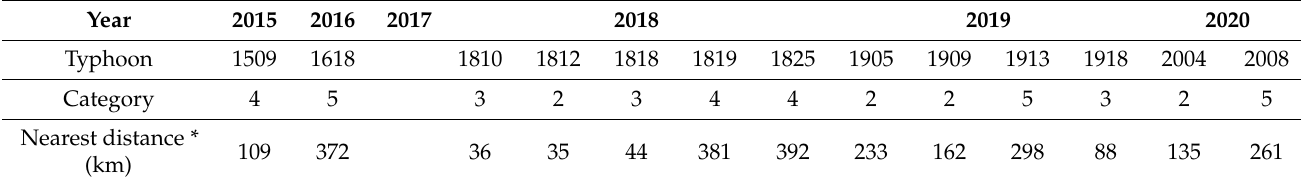
Table 1. List of the significant typhoons (nearest distance ≤ 400 km) occurred from 2015 to 2020 based on the China Meteorological Administration tropical cyclone database [46,47].